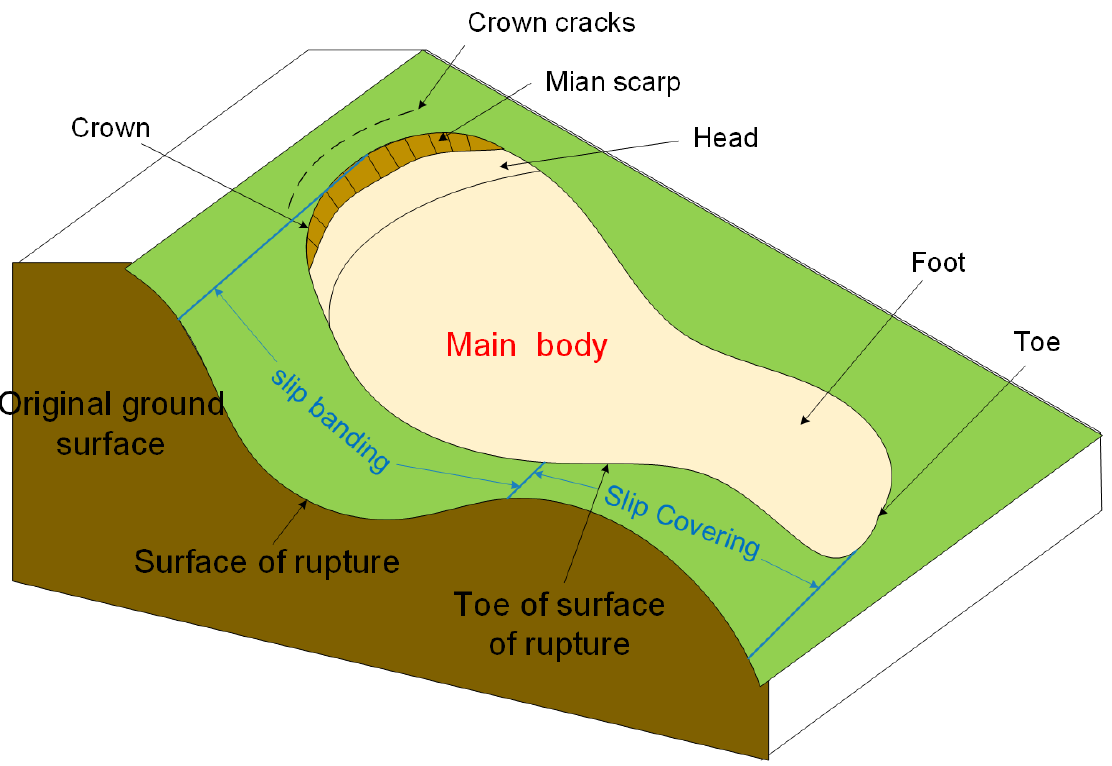
Figure 6. Schematic diagram showing landslide characteristics.